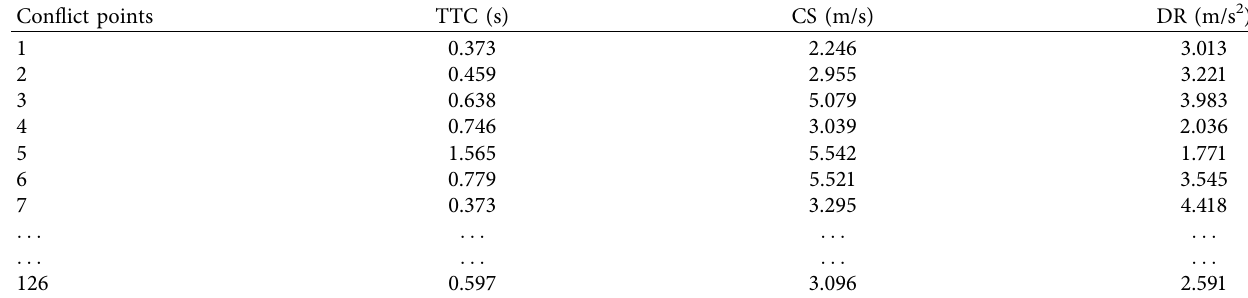
Figure 9: Diagram of calculating indicators. Table 3: The dataset of conflict points.